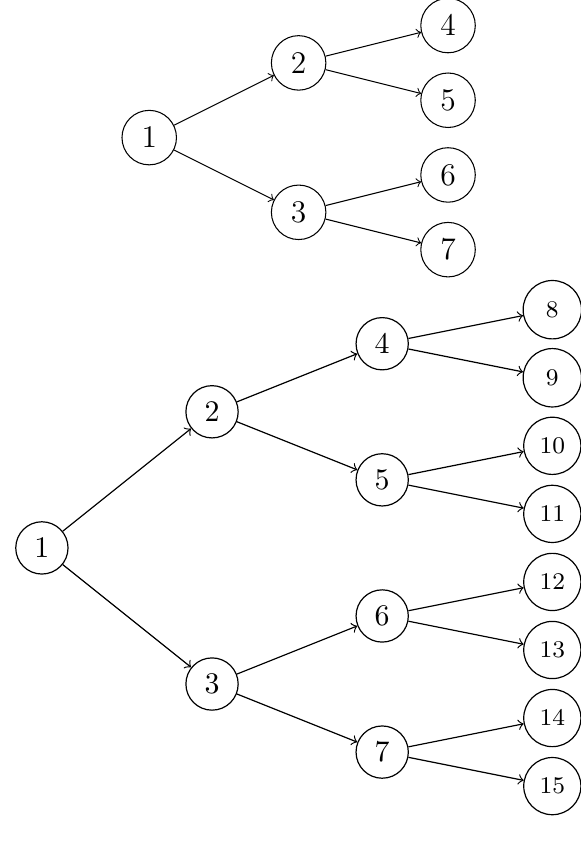
Figure 5: Binary Υ